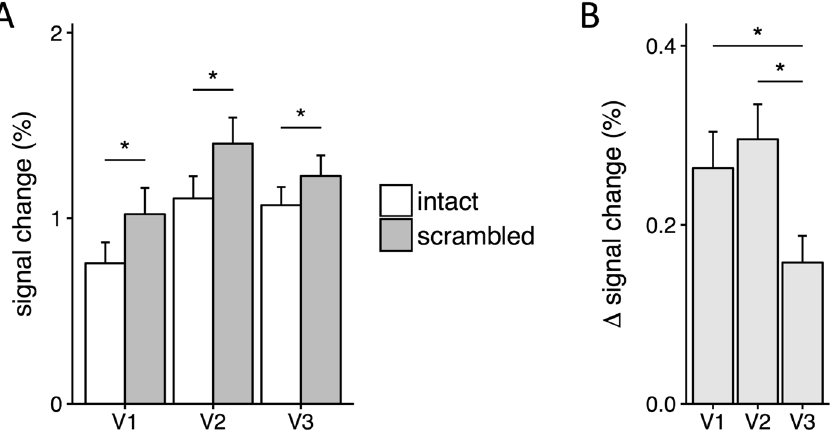
Figure 3. ( A ) Magnitude of response to intact and scrambled images. Scrambled images evoked more activity than intact images in each visual area. ( B ) Differences in response to intact and scrambled images for each visual region. V3 showed a smaller difference in response to intact and scrambled images compared to V1 and V2. Error bars show ± 1 SEM. * p < 0.05, FDR